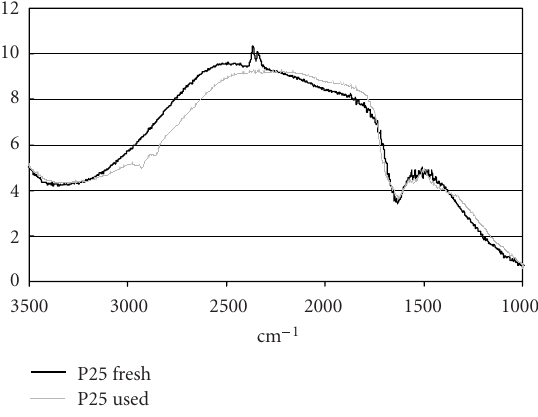
Figure 10: FTIR spectra of fresh and used P25